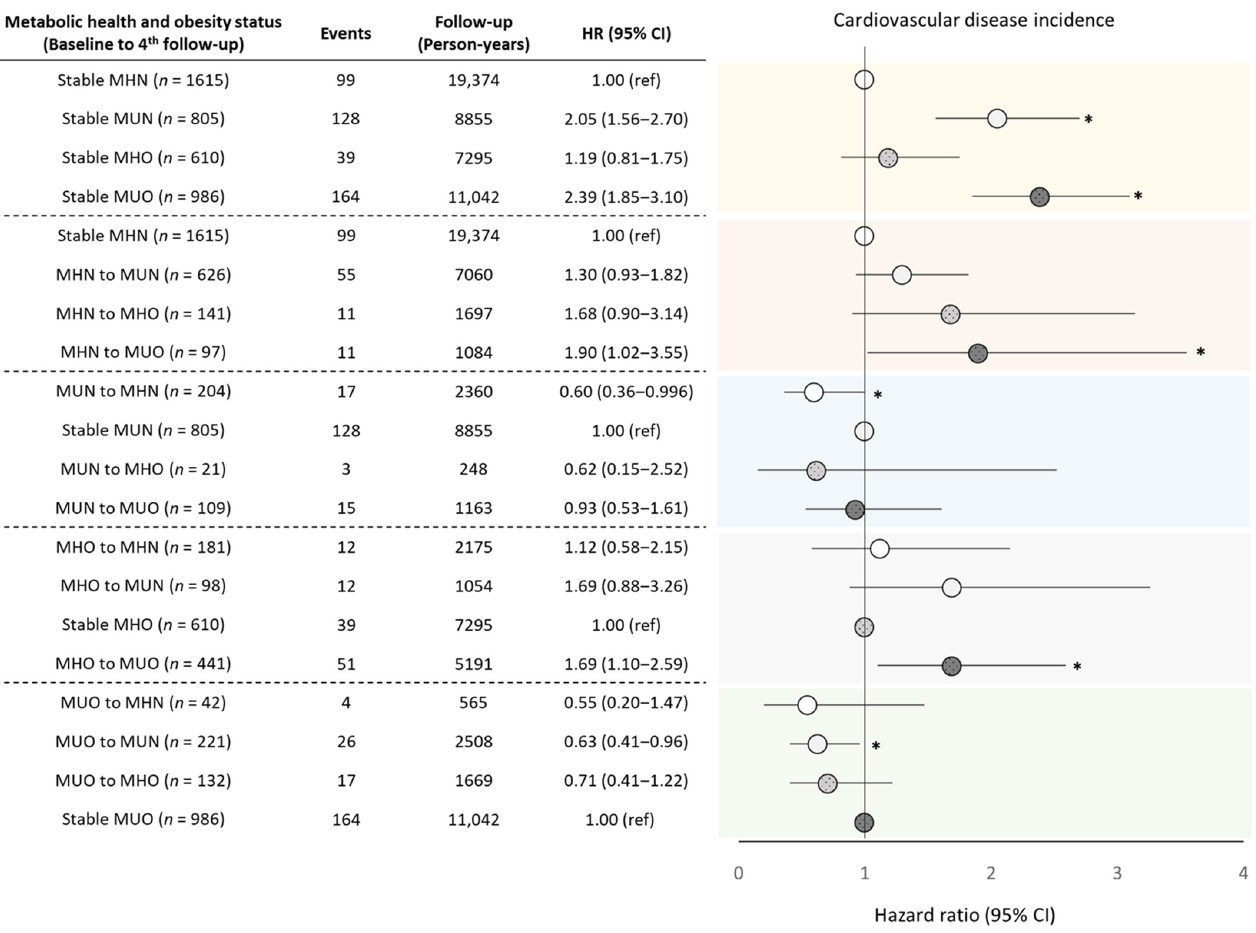
Figure 4. Hazard ratios (HRs) and 95% confidence intervals (Cis) for cardiovascular incidence ac- cording to the combination of metabolic health and obesity status at baseline and fourth follow-up. * p -value < 0.05. p -value was estimated using Cox proportional hazard regression model. MHN: metabolically healthy non-obese; MHO: metabolically healthy and obese; MUN: metabolically un- healthy non-obese; MUO: metabolically unhealthy obese; n : Number. Compared to adults with consistent MHN, stable MHO had a lower risk of cancer incidence, though the HR did not reach significance (HR: 0.76 [95% CI: 0.48–1.18]; Table 5). Few associations were observed between the transition of metabolic health and obesity status and cancer incidence. Compared to those with a stable MHO phenotype, adults that transitioned from MHO to MHN had a higher risk for cancer (HR: 1.95 [95% CI: 1.02– 3.76]). These results indicate that MHO may be more protective of cancer incidence com- pared to MHN. Table 5. Hazard ratios (HRs) and 95% confidence intervals (CIs) for cancer incidence according to the combination of metabolic health risks and obesity status at baseline and fourth follow-up. Metabolic Health and Obesity Status